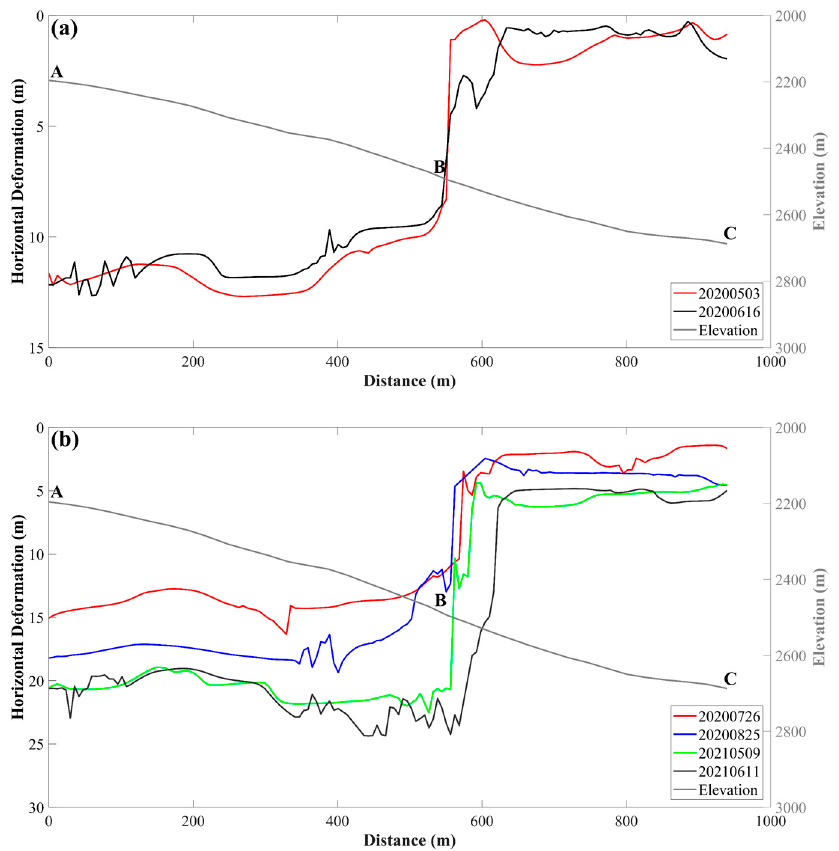
Figure 11. Profile plot along the profile line ABC for the ( a ) first time series stage from 3 May 2020 to 16 June 2020 and ( b ) second time series stage from 26 July 2020 to 11 June 2021. The location of profile line ABC is indicated in Figure 7.